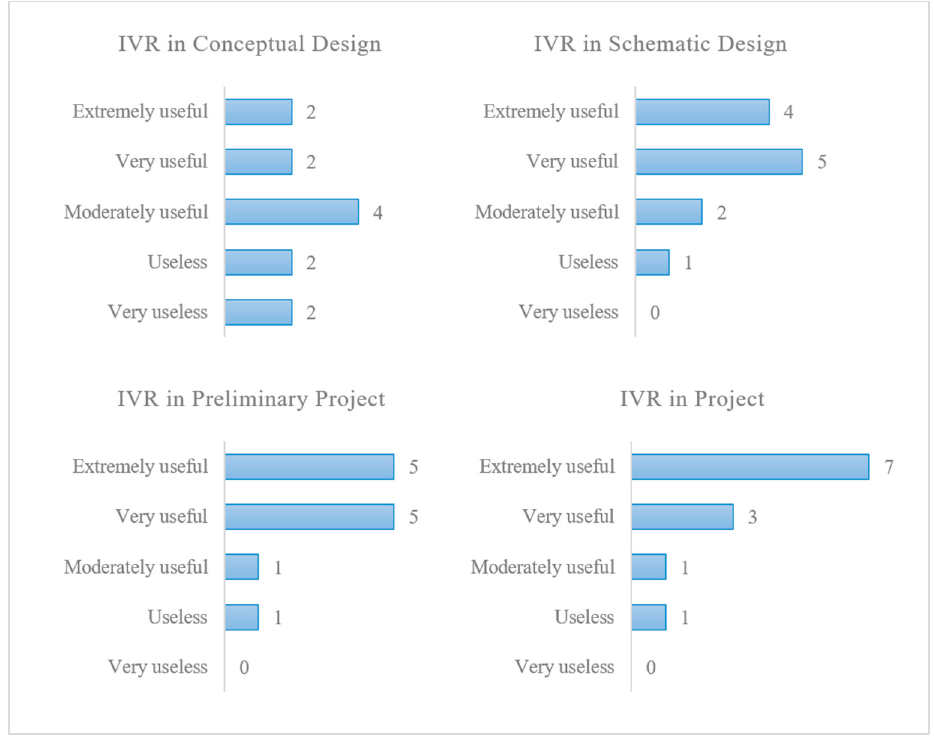
Figure 9. The most highly rated usefulness of IVR through the various phases of architectural design, according to teachers.